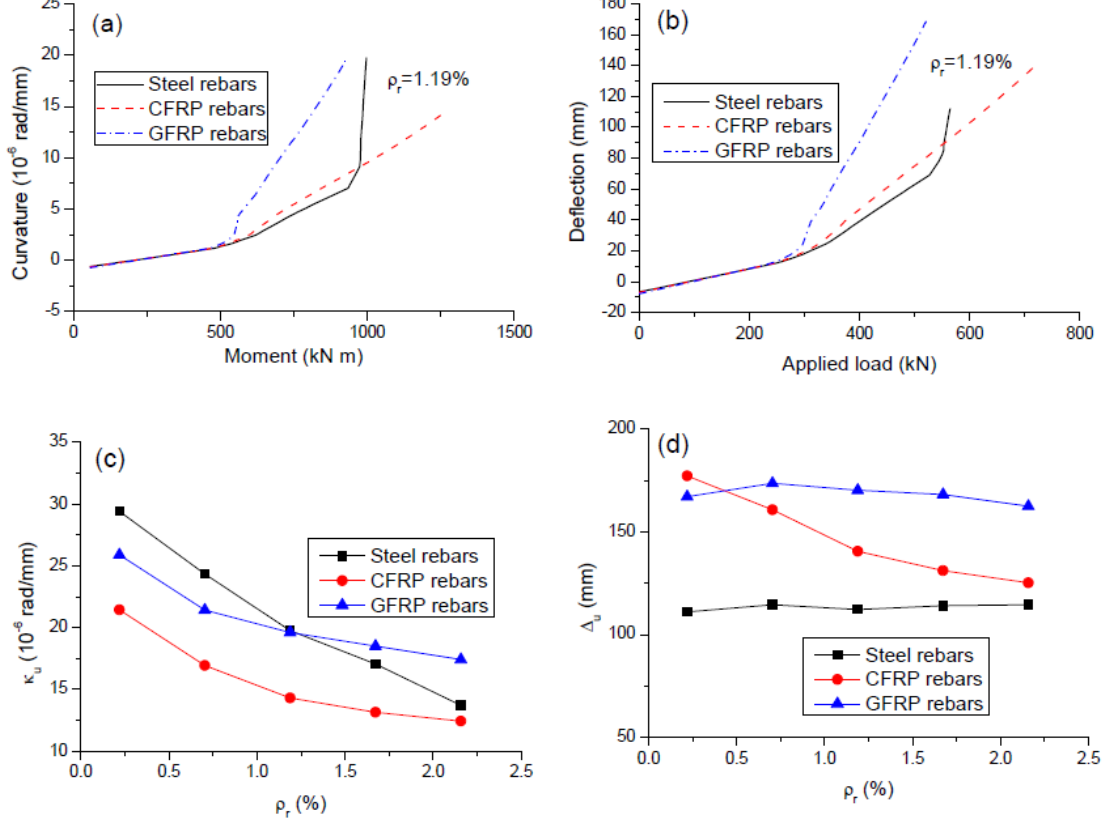
Figure 8. Deformation behavior for the beams with different types of rebars. ( a ) moment versus curvature at midspan; ( b ) load versus midspan deflection; ( c ) variation of ultimate curvature with varying ρ r ; ( d ) variation of ultimate deflection with varying ρ r.